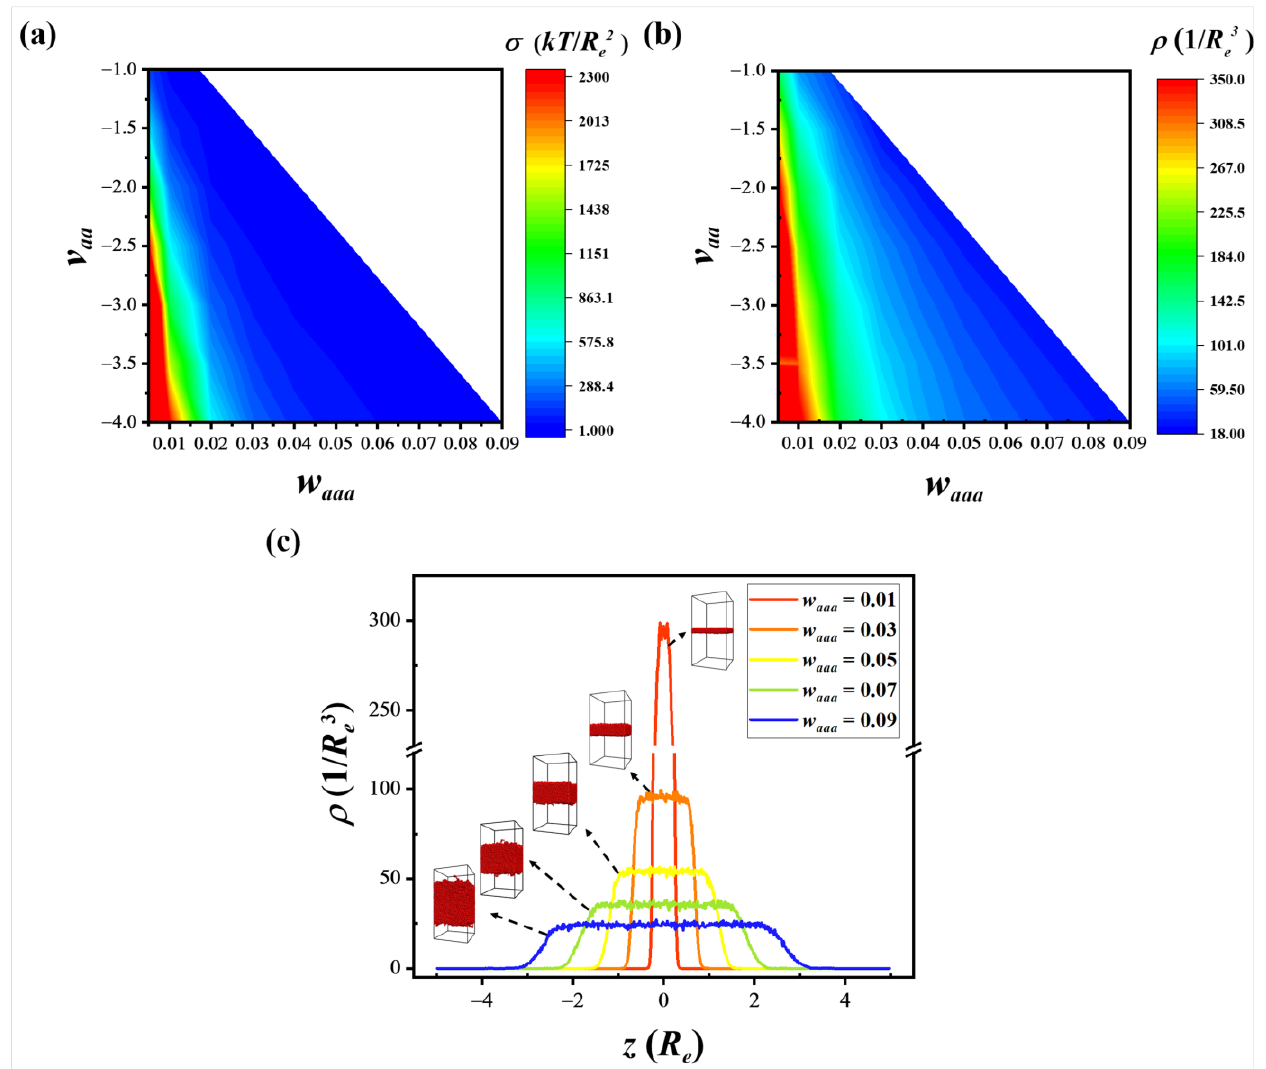
Figure 2. Relationships of model parameters to collective properties obtained from simulations of multichain homopolymer systems. Colormaps of ( a ) surface tension ( σ ) and ( b ) chain density ( ρ ) for different combinations of v aa and w aaa in the poor solvent region, obtained from MD-GL simulations; ( c ) variations in chain density along the z-direction of systems simulated at different w aaa values with v aa fixed at −4.0. The insets in ( c ) show snapshots of the obtained equilibrated configurations for the simulated systems.